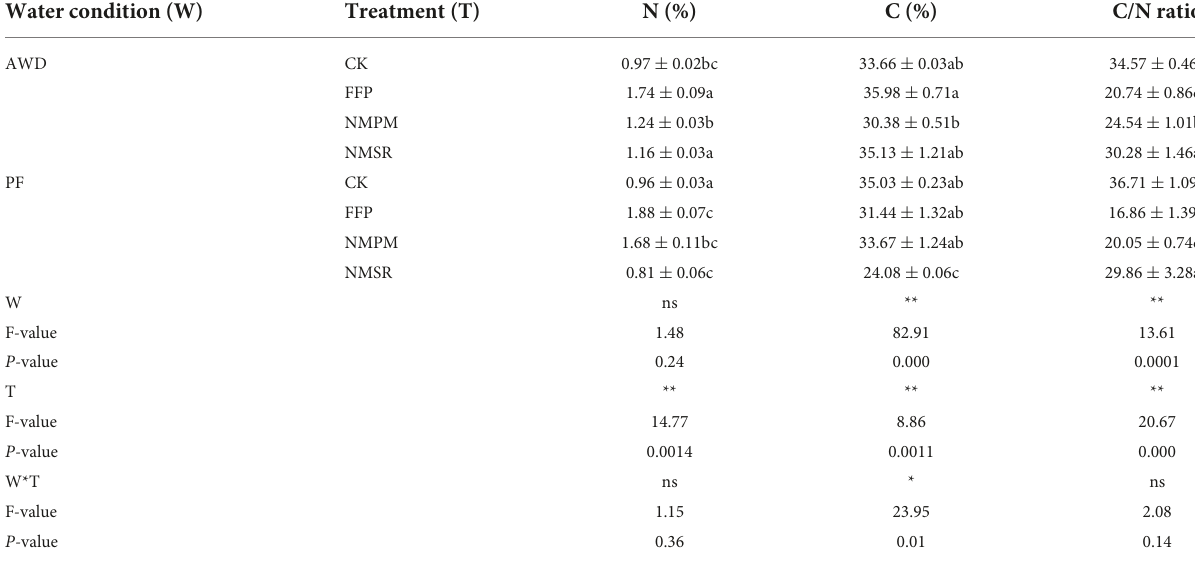
TABLE 1 Combined effects of different fertilizer treatments during alternate wetting and drying (AWD) and permanent flooding (PF) on inorganic nutrients in root. Water condition (W)